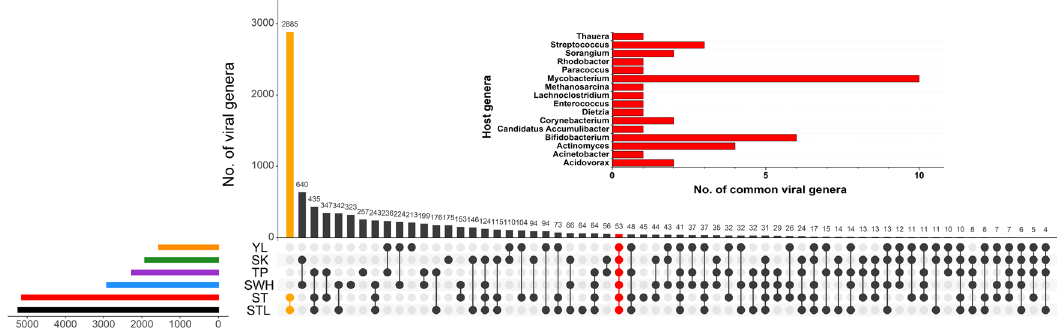
Fig. 2 Shared viral genera in each WWTP. The UpSet 55 chart shows the total number of viral genera and their sharedness in each WWTP. The bar chart on the top right shows the distribution of predicted hosts for common viral genera in all WWTPs. Shared viral genera between ST and STL were labeled orange and shared viral genera in all WWTPs were labeled red. Source data are provided as a Source Data fi le.